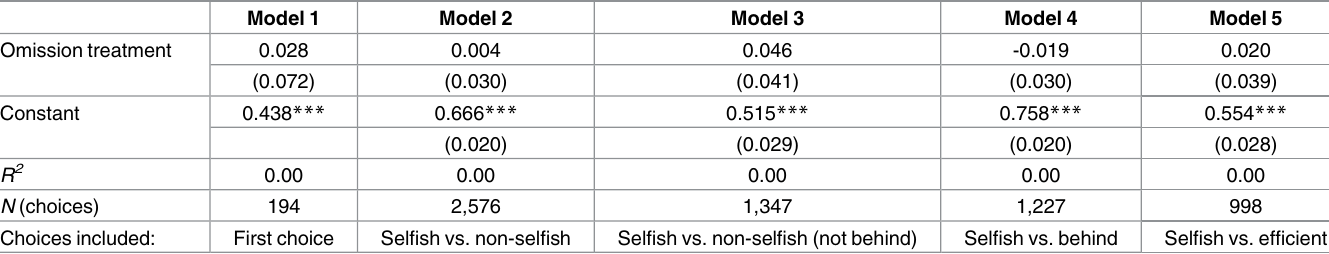
Table 3. Treatment effect on the propensity to choose the selfish